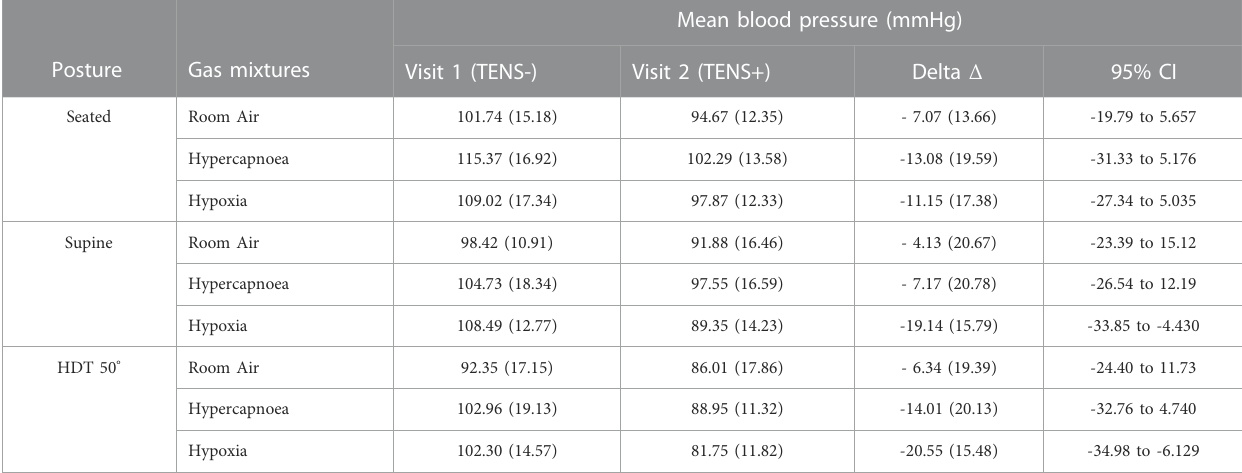
TABLE 3 Mean blood pressure with and without electrical stimulation in seated, supine and HDT postures. Data are presented as mean (SD), HDT: head down tilt. TENS-, electrical current off. TENS + electrical current turned on. 95% CI, 95% con fi dence interval.